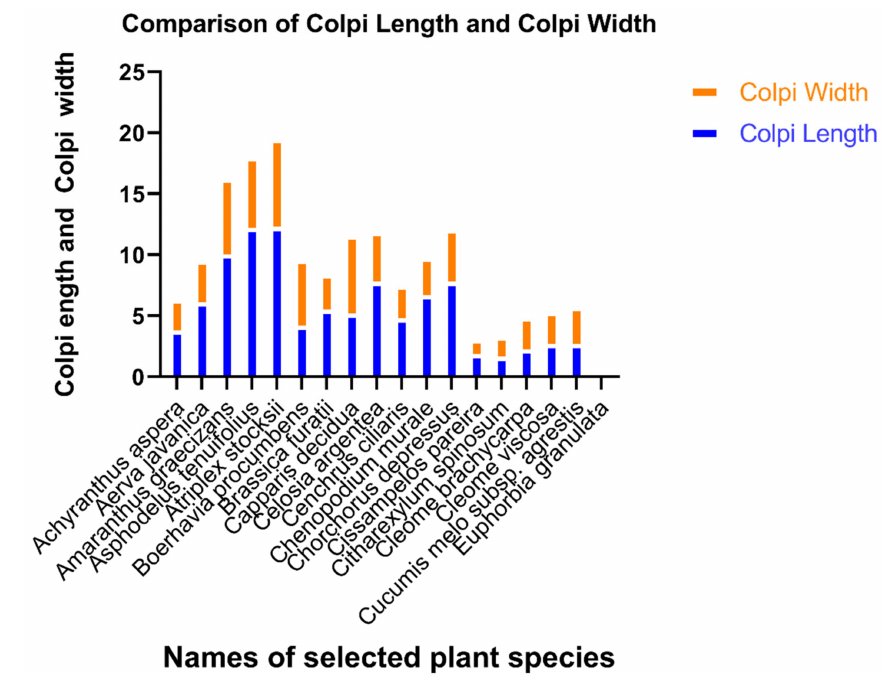
Figure 6. Comparison of the Colpi length and width ( µ m) of selected plant